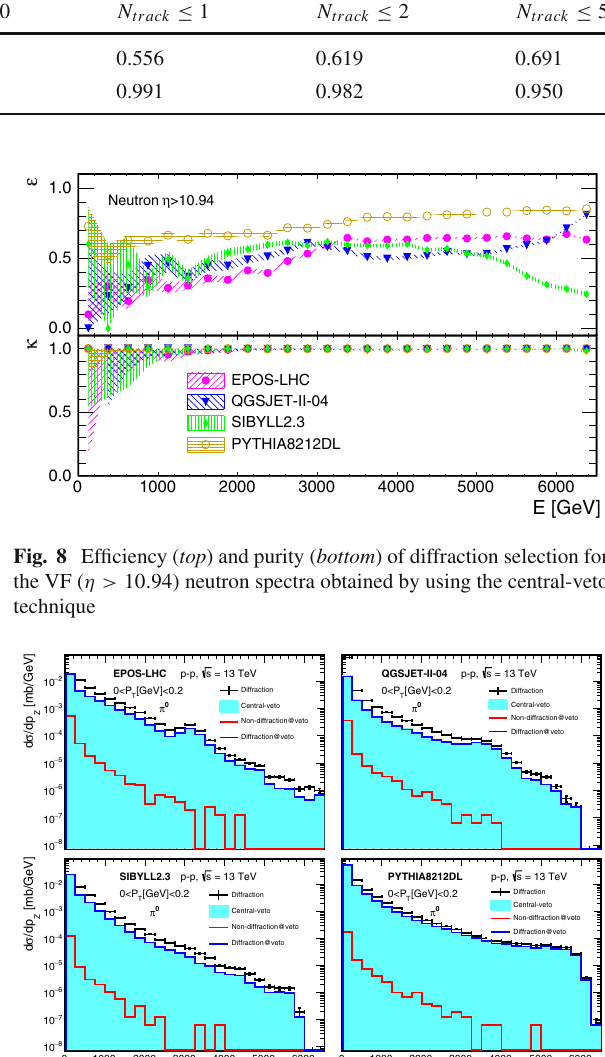
M X of ∼ 13 and 1300 GeV at